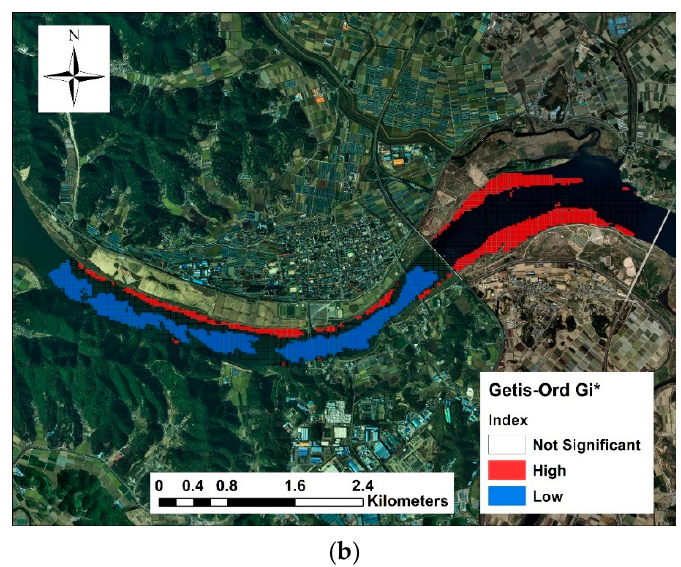
Figure 7. HAB-prone regions based on hot-spot analysis in the downstream vicinity of the Nakdong and Nam rivers confluence: ( a ) K-means clustering method and ( b ) Getis-Ord G* method. The red-colored areas correspond to HAB-prone regions, blue-colored areas indicate a region with a reduced likelihood of an HAB, and the remaining black-colored areas are not subject to any category.